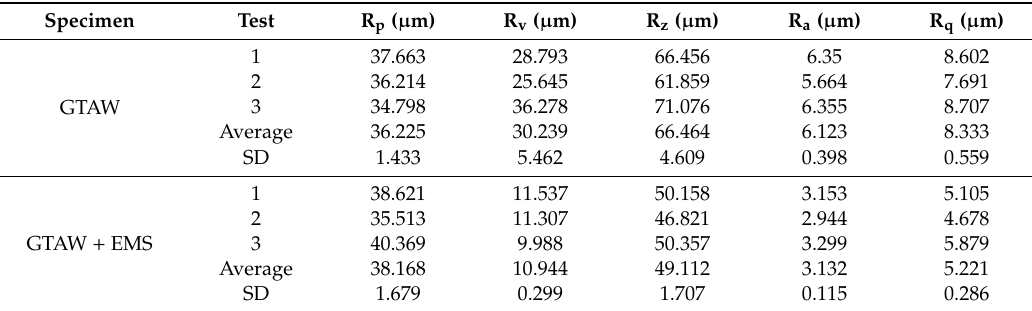
Table 2. The roughness parameters of the weld surface.